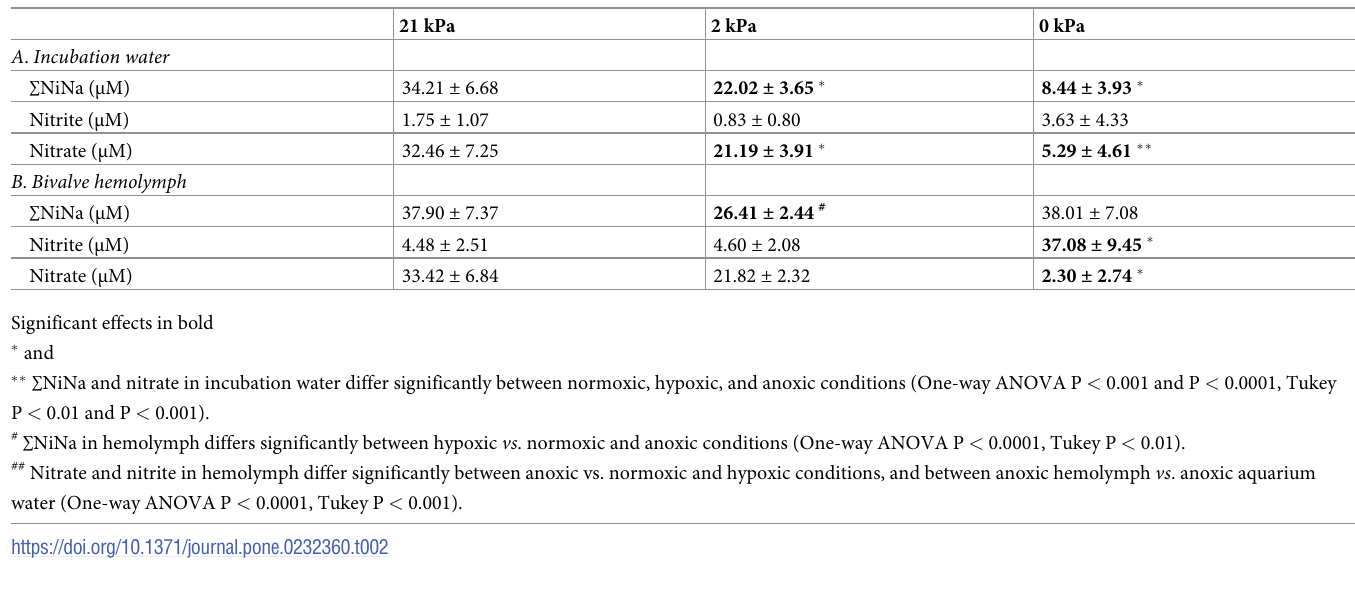
Table 2. Concentration of nitrite, nitrate and the sum of both ( ∑ NiNa) in incubation water (A.) and hemolymph of Arctica islandica (B.) after 3.5 days of normoxic (21 kPa), hypoxic (2 kPa), or anoxic (0 kPa) incubation. Mean ± SD, n =